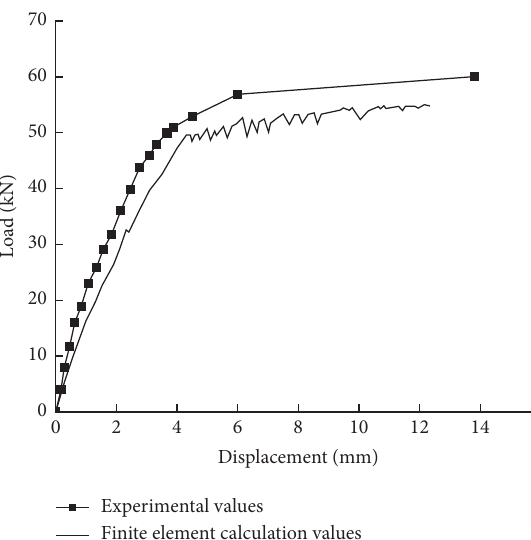
Figure 12: Load-deflection curve of test beam BM6-1.